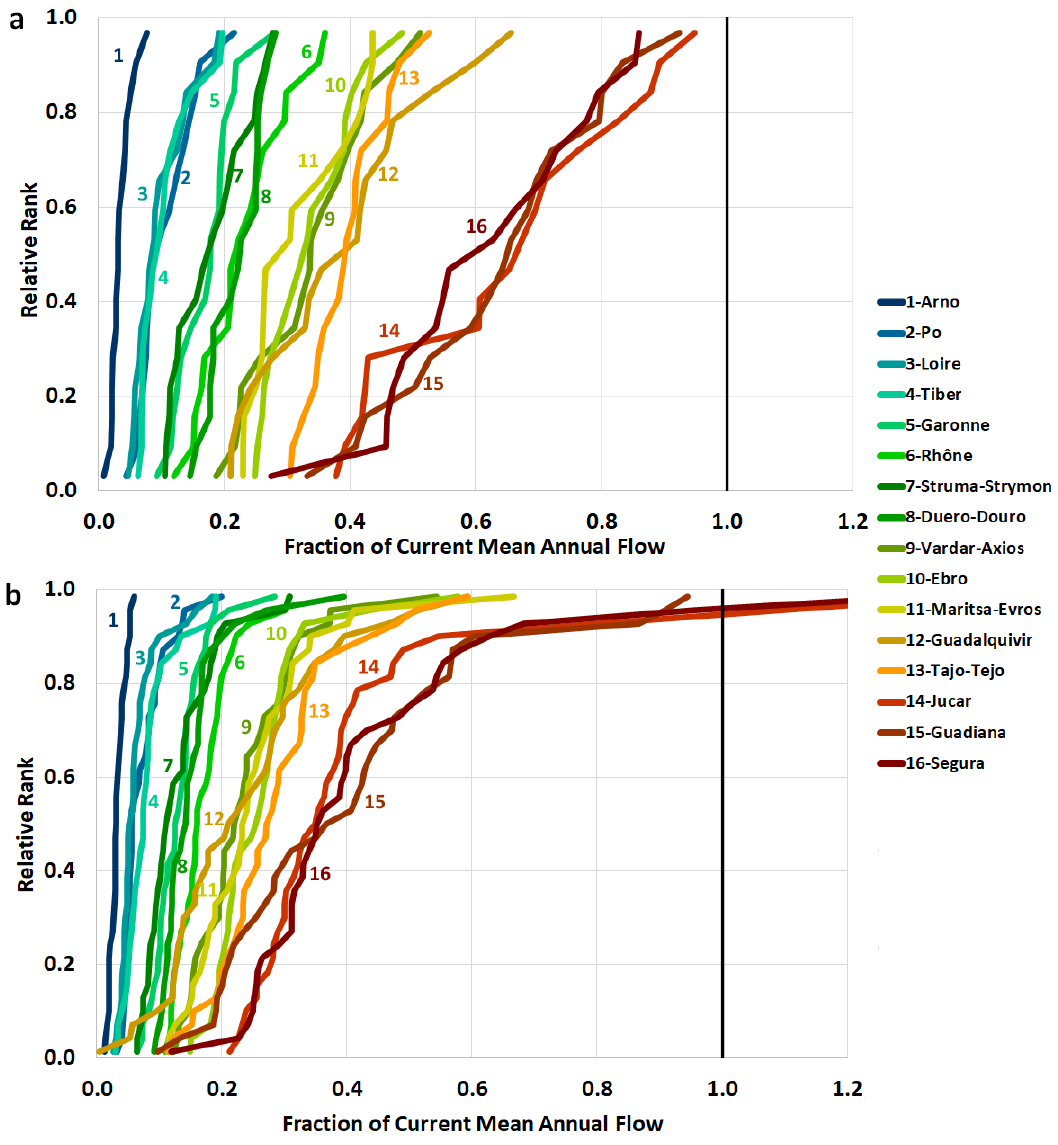
Figure 6. Estimated cumulative probability distribution function of Potential Water Availability (PWA) expressed as a fraction of current Mean Annual Flow (F) in the 16 basins under study. ( a ) historical period; ( b ) long-term